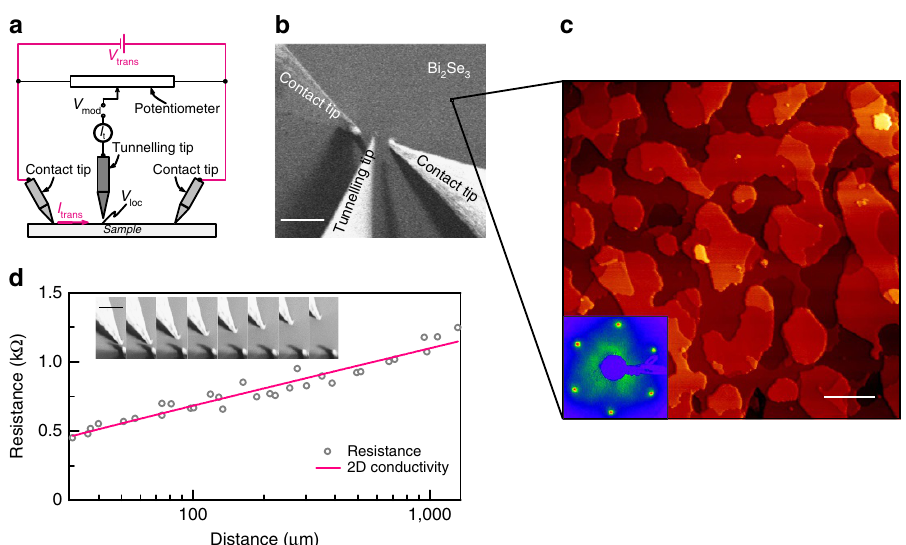
Figure 1 | SEM, STM, LEED and sheet conductance of Bi 2 Se 3 on Si(111). ( a ) Scheme of the STP experiment: a voltage V trans leading to a transverse current I trans is applied to the sample by two tips (red circuit). A potentiometer connects the tunnelling tip to the sample contacts in a Wheatstone bridge circuit. V loc represents the local potential at the surface under the tunnelling tip. ( b ) SEM image of the contact geometry. Scale bar, 75 m m. Two Au tips contact the Bi 2 Se 3 sample surface. A W tip is operated in tunnelling distance (tunnelling tip) and simultaneously maps the surface structure and the electrochemical potential. ( c ) STM image of the 14 QL Bi 2 Se 3 film on Si(111) ( V t ¼ 1V, I t ¼ 12pA, 650 (cid:4) 650nm 2 ). Scale bar, 100nm. The surface of the Bi 2 Se 3 film is crystalline and flat. The inset shows the hexagonal LEED pattern of the Bi 2 Se 3 film at 35eV (lattice constant of 0.41 ± 0.01nm) exhibiting the high crystallinity of the film. ( d ) Distance-dependent resistance measurement of the Bi 2 Se 3 film, leading to a sheet conductance of 1.8 ± 0.1mS. The inset shows SEM image snapshots of the measuring process. Scale bar, 75 m